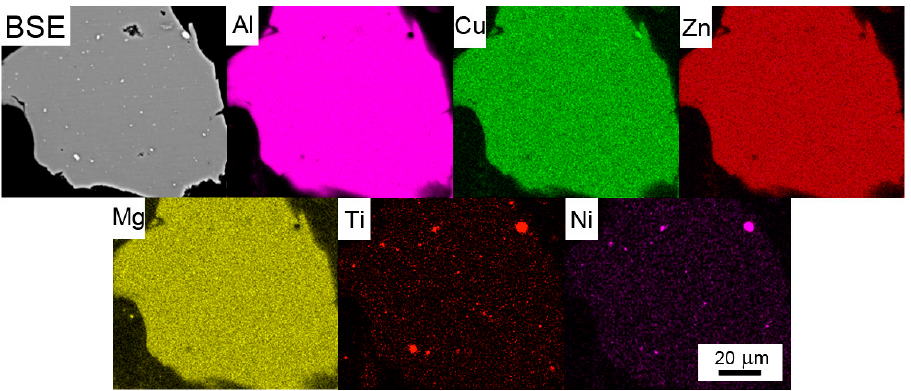
Figure 4. Element distribution in an atomized Al7075Zr_A powder particle with a cellular microstructure. BSE and the corresponding SEM-EDS maps.